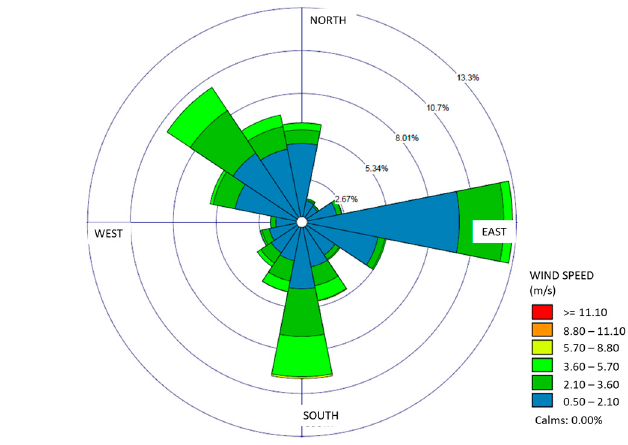
Figure 1. Geographical location of Porto area, Port of Leixões: North region of Portugal. The Port of Leixões is located in the north region of mainland Portugal at 41° 11 ′ N, 8° 40 ′ W.